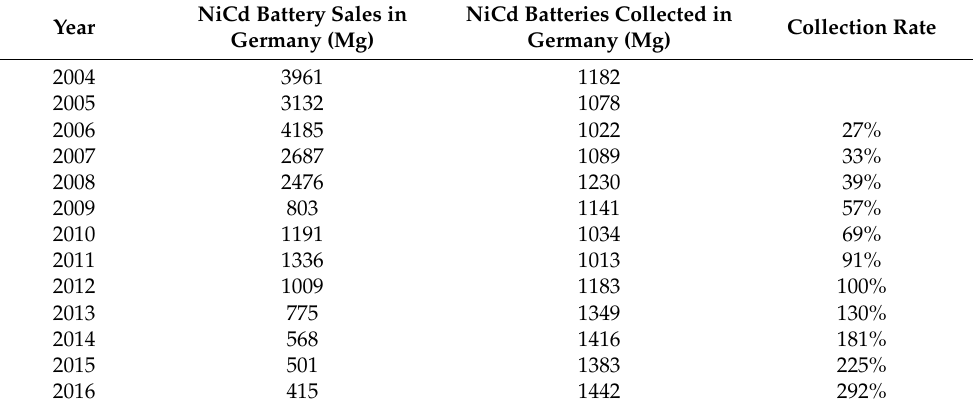
Table 2. NiCd batteries and accumulators sold and collected (Data from [67,68]). Collection rate = mass of collected batteries in relation to the average weight (=mass) of batteries sold in the calendar year and the two preceding years.